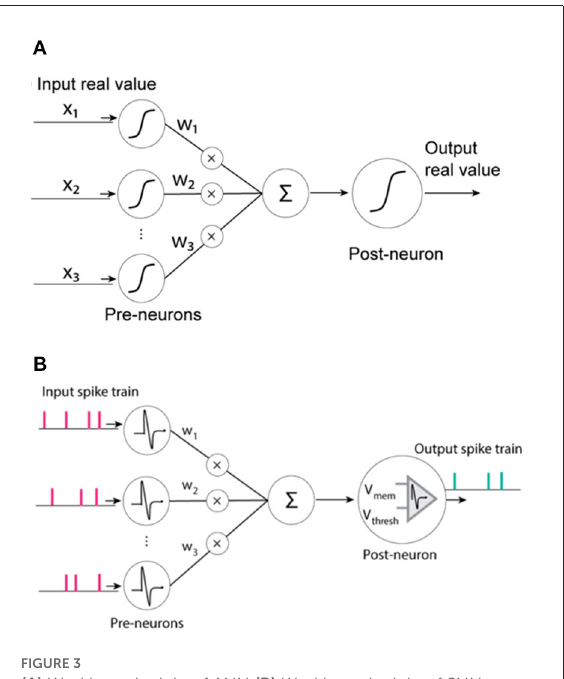
FIGURE3 (A) Working principle of ANN (B) Working principle of SNN (Zhang,